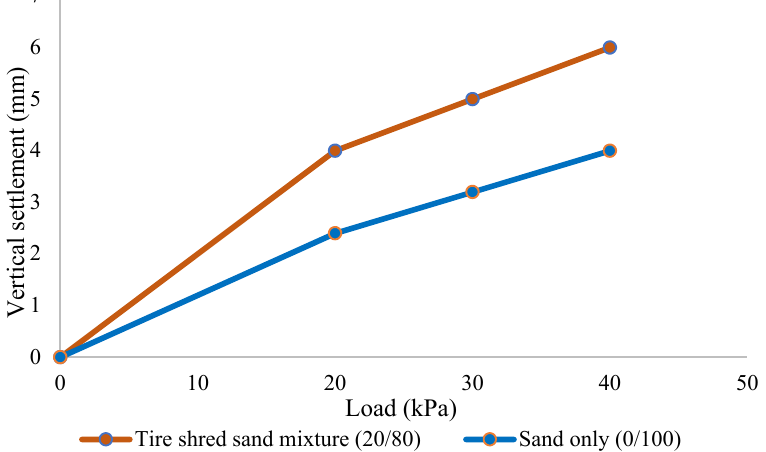
Figure 13. Comparative graph of vertical settlement for sand only (0/100) and tire shred-sand mixture (20/80) in Plaxis 3D.